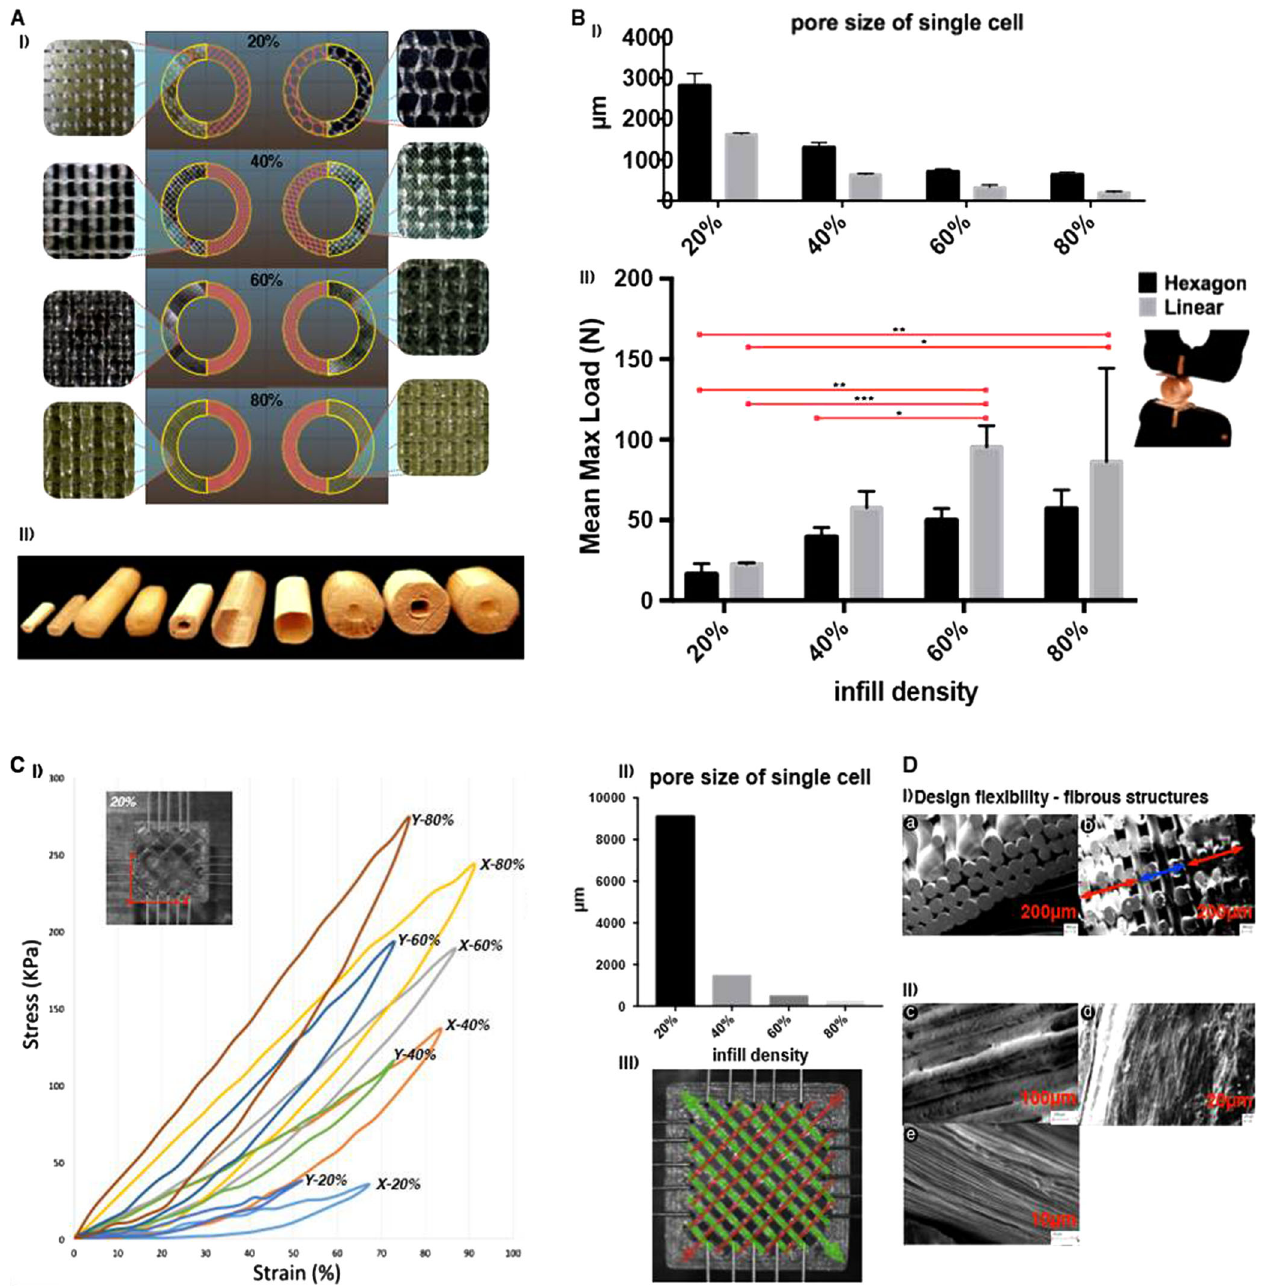
Fig. 1 Architectural and mechanical biomimetic design fl exibility with direct 3D printed thermoplastic polyurethane. a (i). 3D hollow tubular CAD (20 mm height × 15 mm diameter) was sliced (Slic3r) to have a range of in fi ll densities in two different in fi ll patterns (hexagonal and linear). Corresponding 3D printed structures were obtained with TPU90 with clear morphological de fi nition. ( n = 6) (ii). A range of 3D printed tubular structures were obtained by varying the basic code (indicated in supplementary methods) for (the wall thickness, in fi ll density and diameter) of the tubular hollow CAD structure for a (i). b (i). The ‘ pore ’ size is signi fi cantly greater in the hexagonal constructs than linear. The increase in in fi ll density decreased ‘ pore ’ size, but an exception observed between 60 to 80% in the hexagonal in fi ll ( P > 0.05). (ii). Compression strength of 3D printed structures corresponding to morphological details described in a (i). The hexagonal in fi ll was signi fi cantly more compliant than the linear in fi ll at 40, 60, 80% ( P < 0.001) but not 20% ( P > 0.05). Overall the linear in fi ll requires signi fi cantly more force to compress ( P < 0.05). c (i) The surface architecture of 3D printed TPU90 scaffolds (15 × 15 × 1.5 mm) with signi fi cantly different fi bre thickness in opposite directions. (ii) Biaxial test demonstrating a density dependant increase in elastic modulus of scaffolds, as well as material anisotropy with signi fi cantly higher compressive stress in y -axis, and greater elongation in x -axis. ( p < 0.05). (iii) The pore size of the scaffolds is inversely related to the in fi ll density ( p < 0.05). d (i) a SEM of a 3D printed TPU90 as a ligament structure that mimics collagen fi bre morphology b with an in fi ll gradient (indicated with double headed arrows ) to modulate varying tissue interphases. (ii) SEM of Porolay (PVA + TPU) biomimicking fi brous morphology as potential substitutes for connective